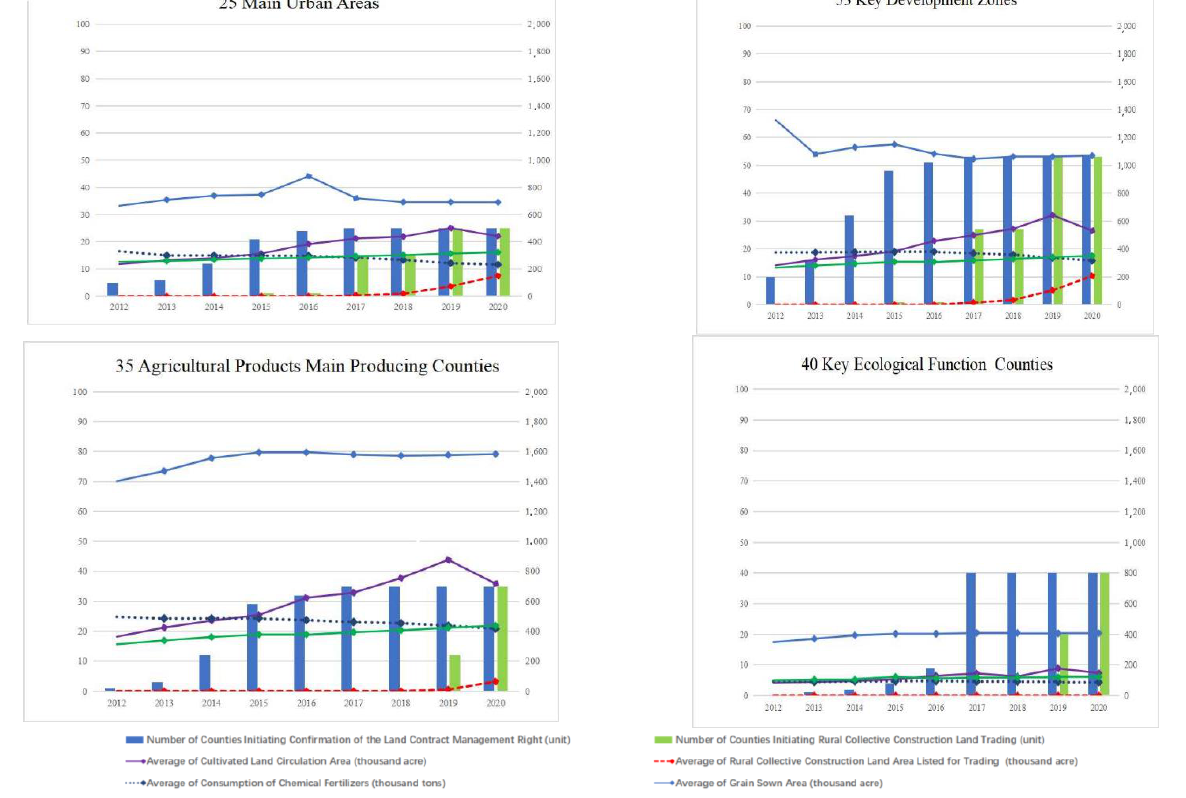
Figure 2. Trends of indicators in promoting rural land system reform in 4 categories of counties. Note : 1. The number of counties initiating confirmation of the land contract management right, the number of counties initiating rural collective construction land trading, arable land circulation area, collective construction land area listed for trading and chemical fertiliser consumption are on the left axis. 2. Grain sown area and total power of agricultural machinery are on the right axis.